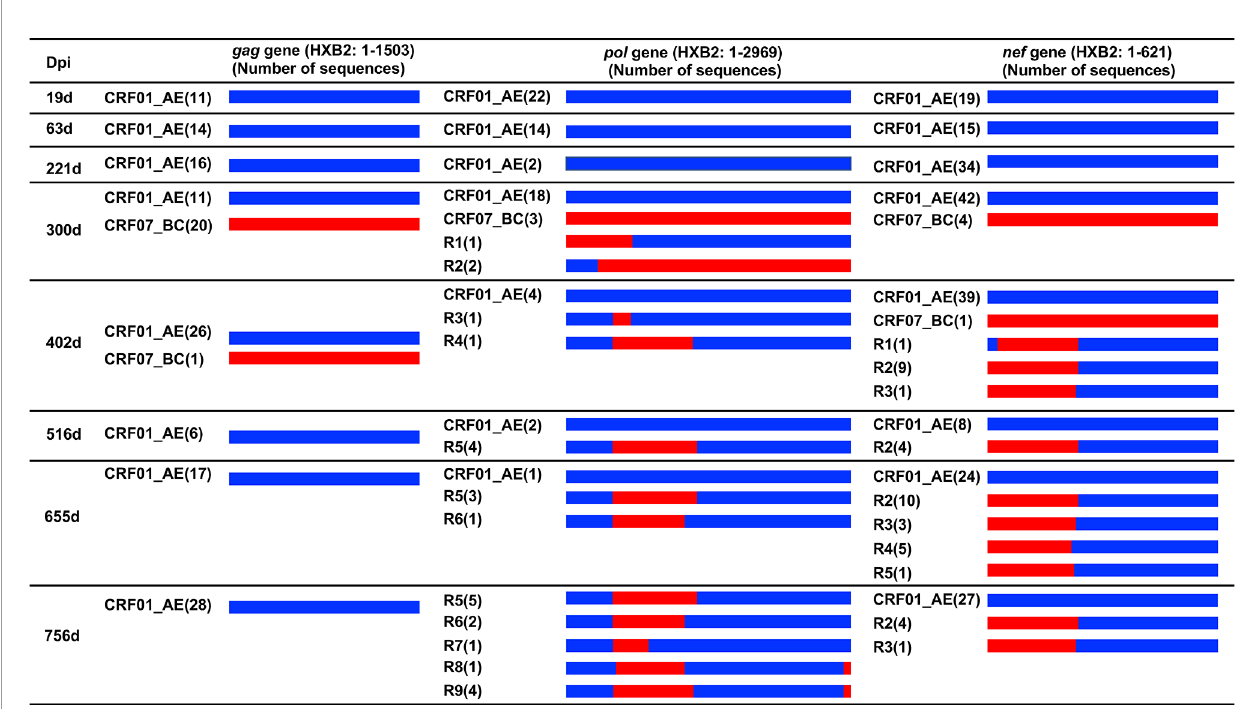
pol ( Supplementary Figure 1 ) and nef ( Supplementary Figure 2 ) gene recombinants were detected, but not gag gene recombinants. The identi fi ed breakpoints are listed in Supplementary Table 2 .